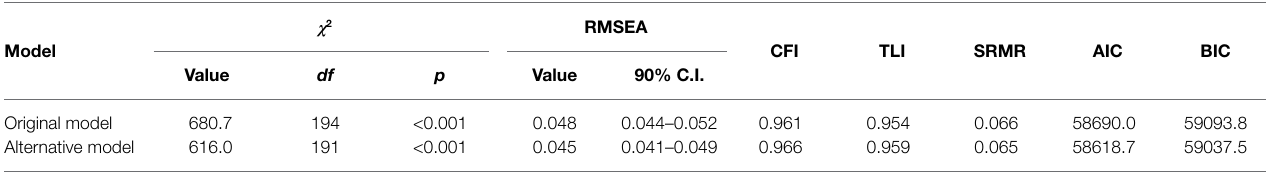
TABLE 3 | Fit statistics for the original model and the alternative model.